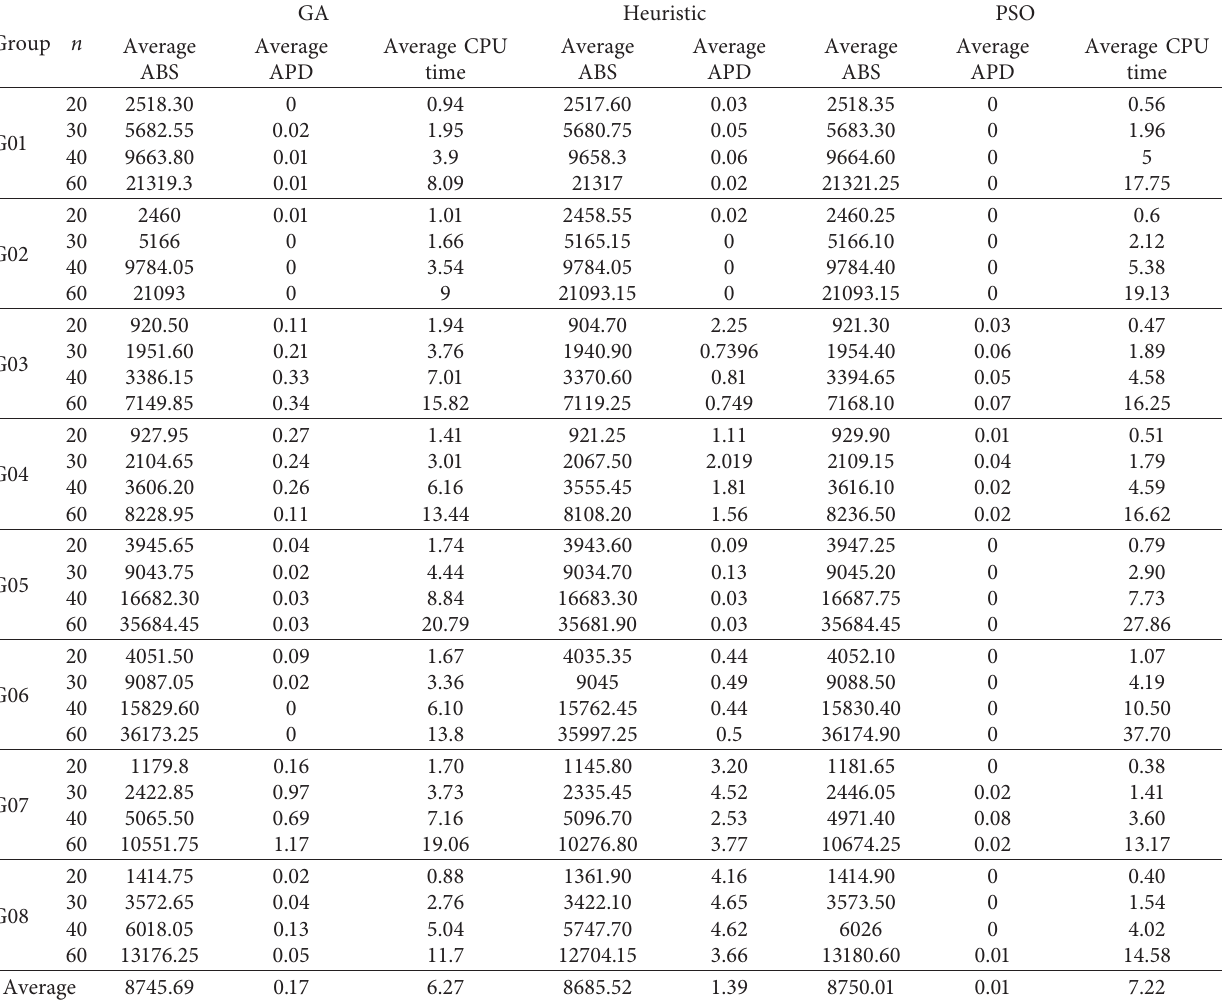
Table 2: Comparison of algorithms of LPP problem in small instances.